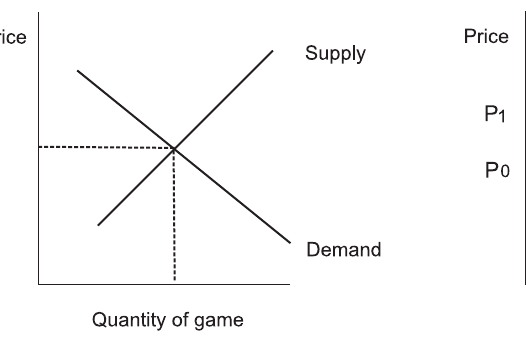
Fig. 2. Interaction of demand and